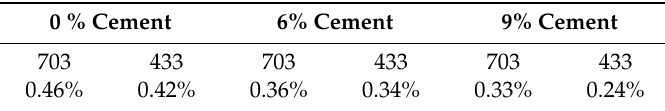
Figure 6. The linear shrinkage curves of rammed earth in conditions of low relative humidity of 35%, depending on the age of the samples and their grain size [53]. Table 5. The linear shrinkage of rammed earth series after one year.